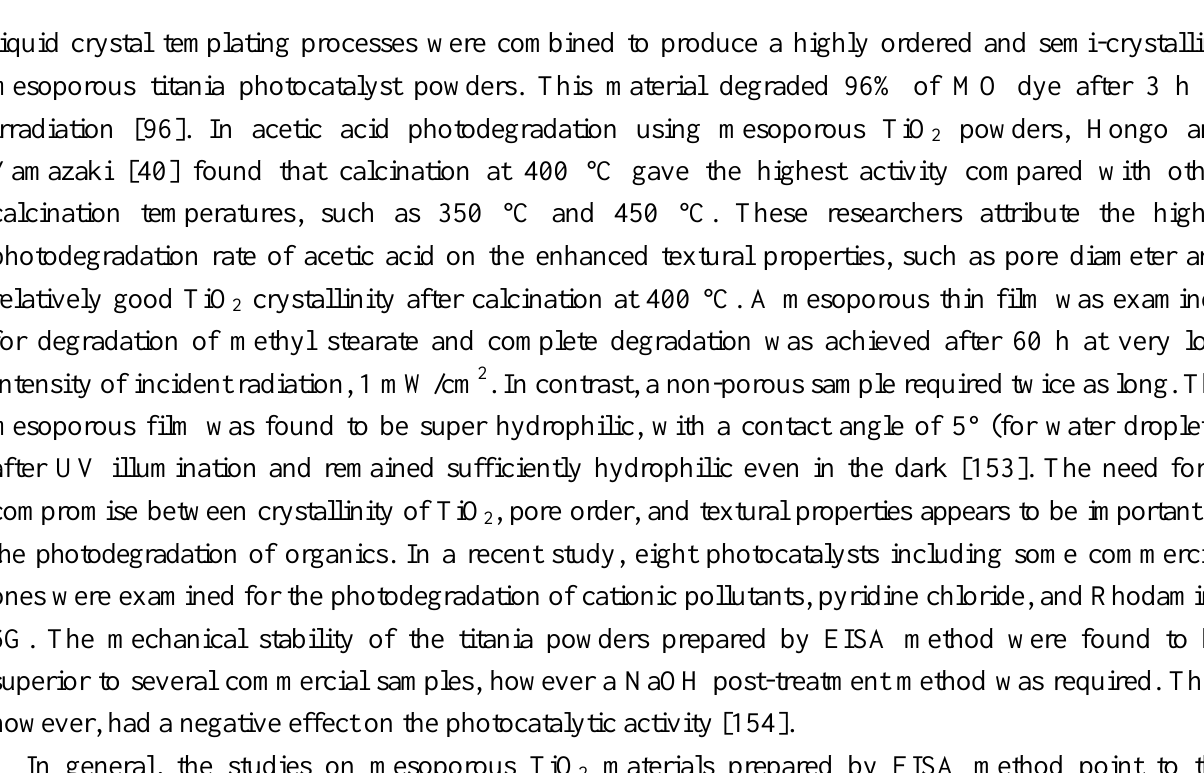
. Reprinted with permission 2